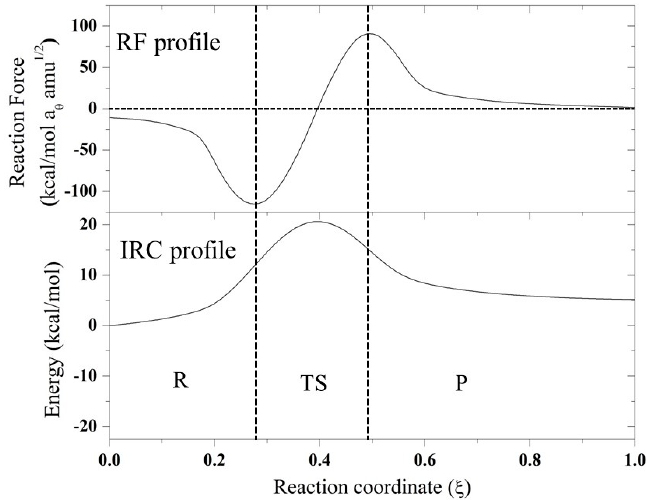
Figure 2. IRC and RF profile for the N-assistance mechanism for compound F.